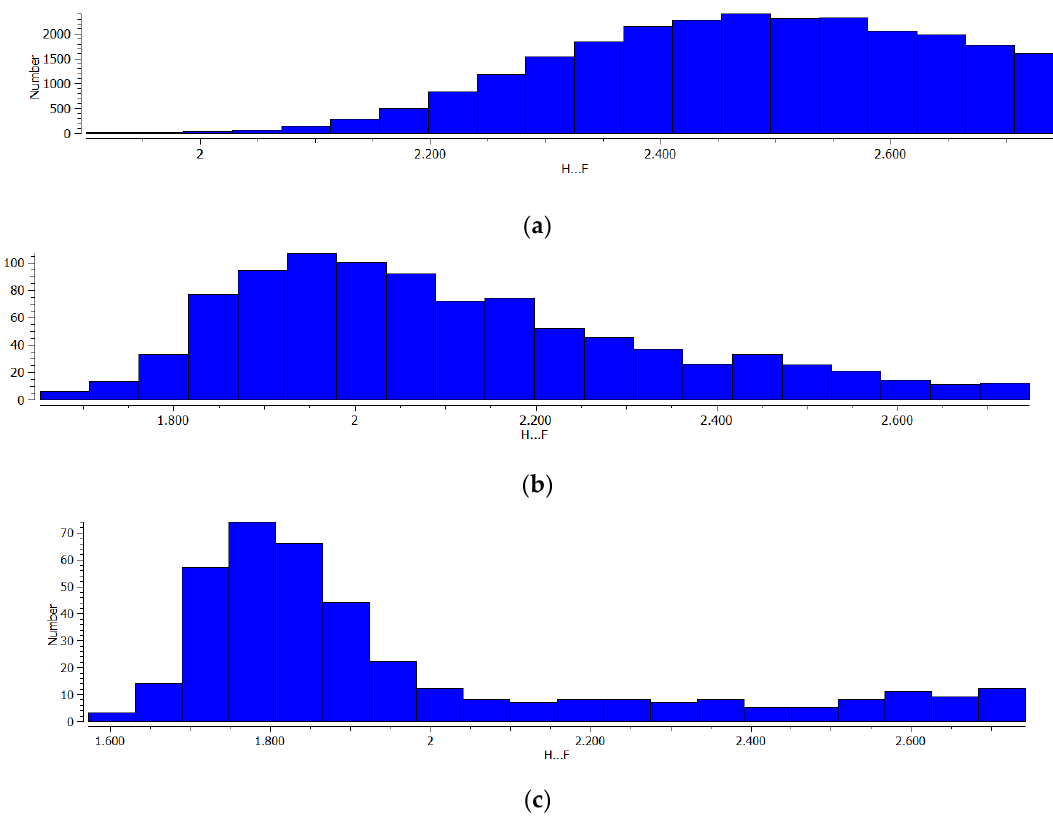
Figure 2. The histograms of the H ... F distances for ( a ) C-H ... F, ( b ) N-H ... F and ( c ) O-H ... F systems taken from CSD and considered in this study.